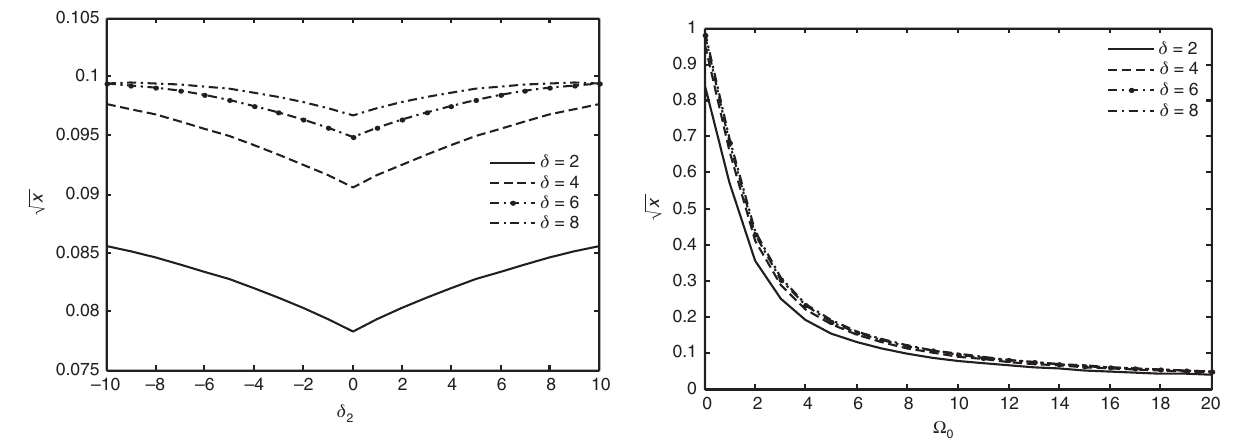
Figure 13: Variations of non-dimensional phase speed ( ) x against rotation parameter Ω